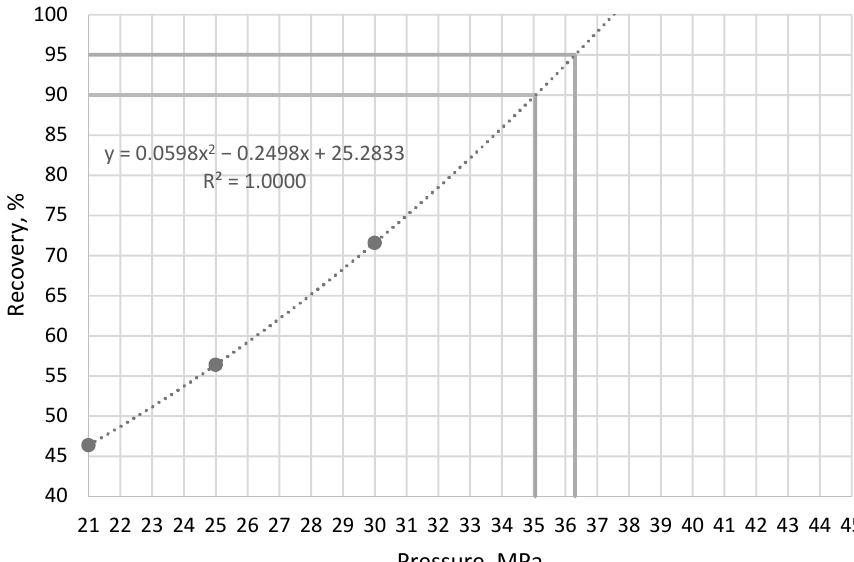
Figure 3. Results of quadratic extrapolation to determine the MMP. Table 1. Results of MMP calculation using statistical regression According to the calculation results, the average MMP value was determined as 37.06 MPa, while the range of values was 35.05–38.79 MPa. The obtained data show a significant variation in the range of MMP values depending on the calculation method. The consid- ered methods for determining MMP use the total value of the displacement efficiency, which depends on the amount of residual oil saturation.